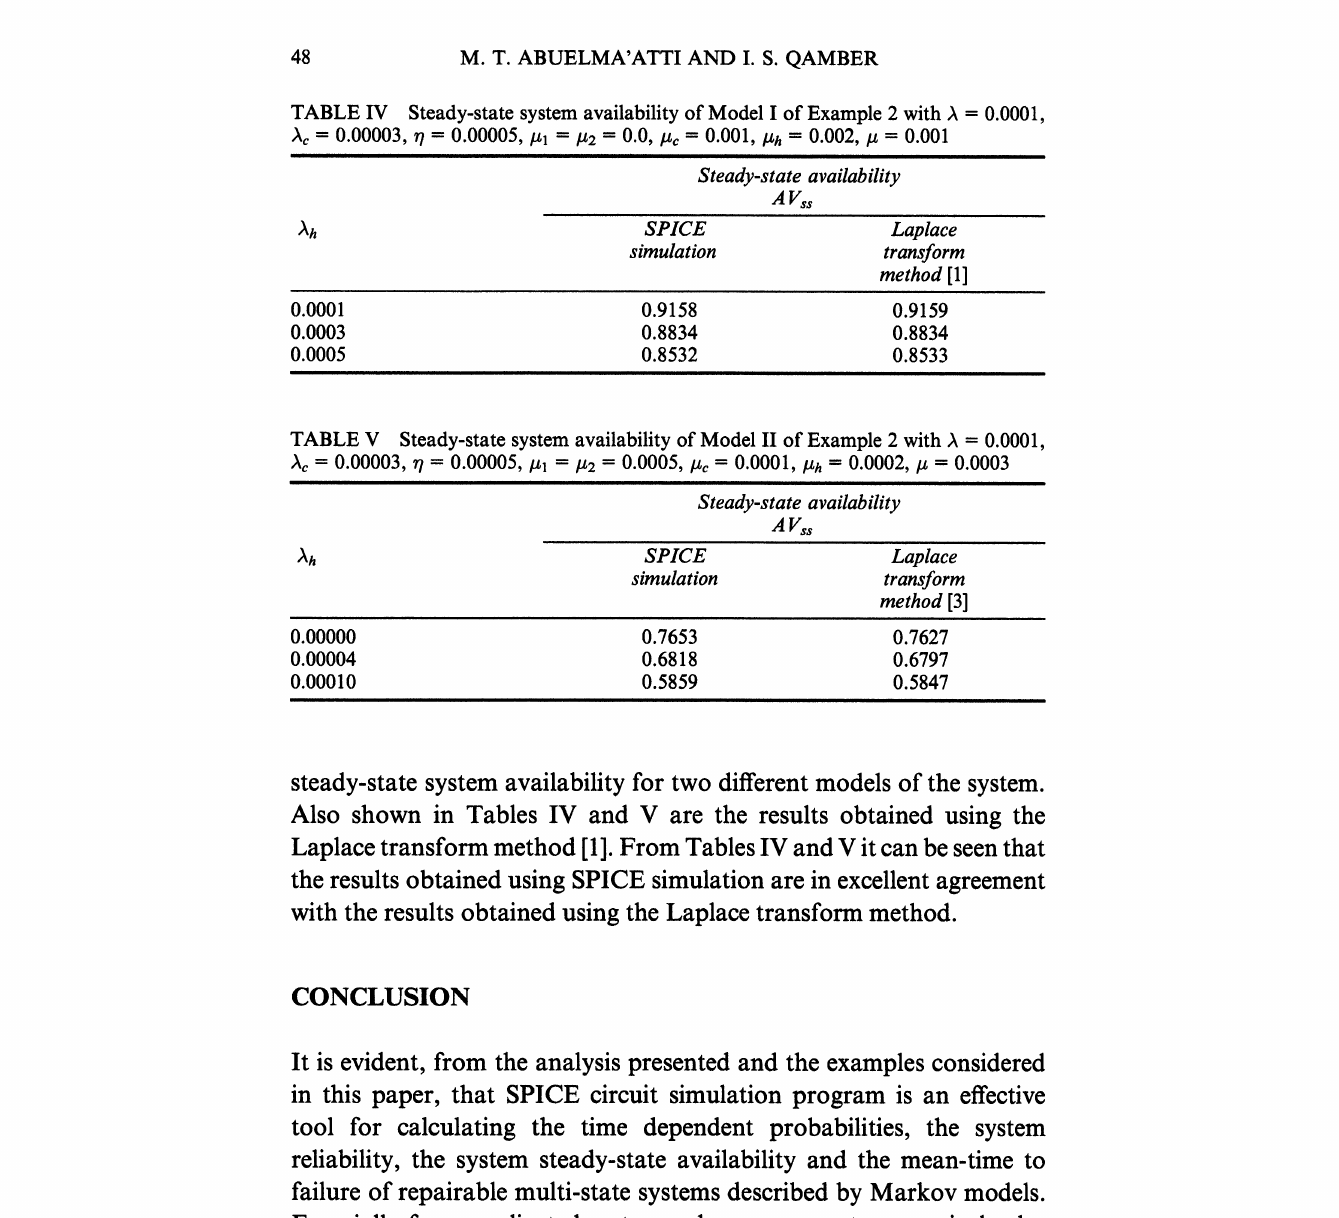
TABLE IV Steady-state system availability of Model of Example 2 with A